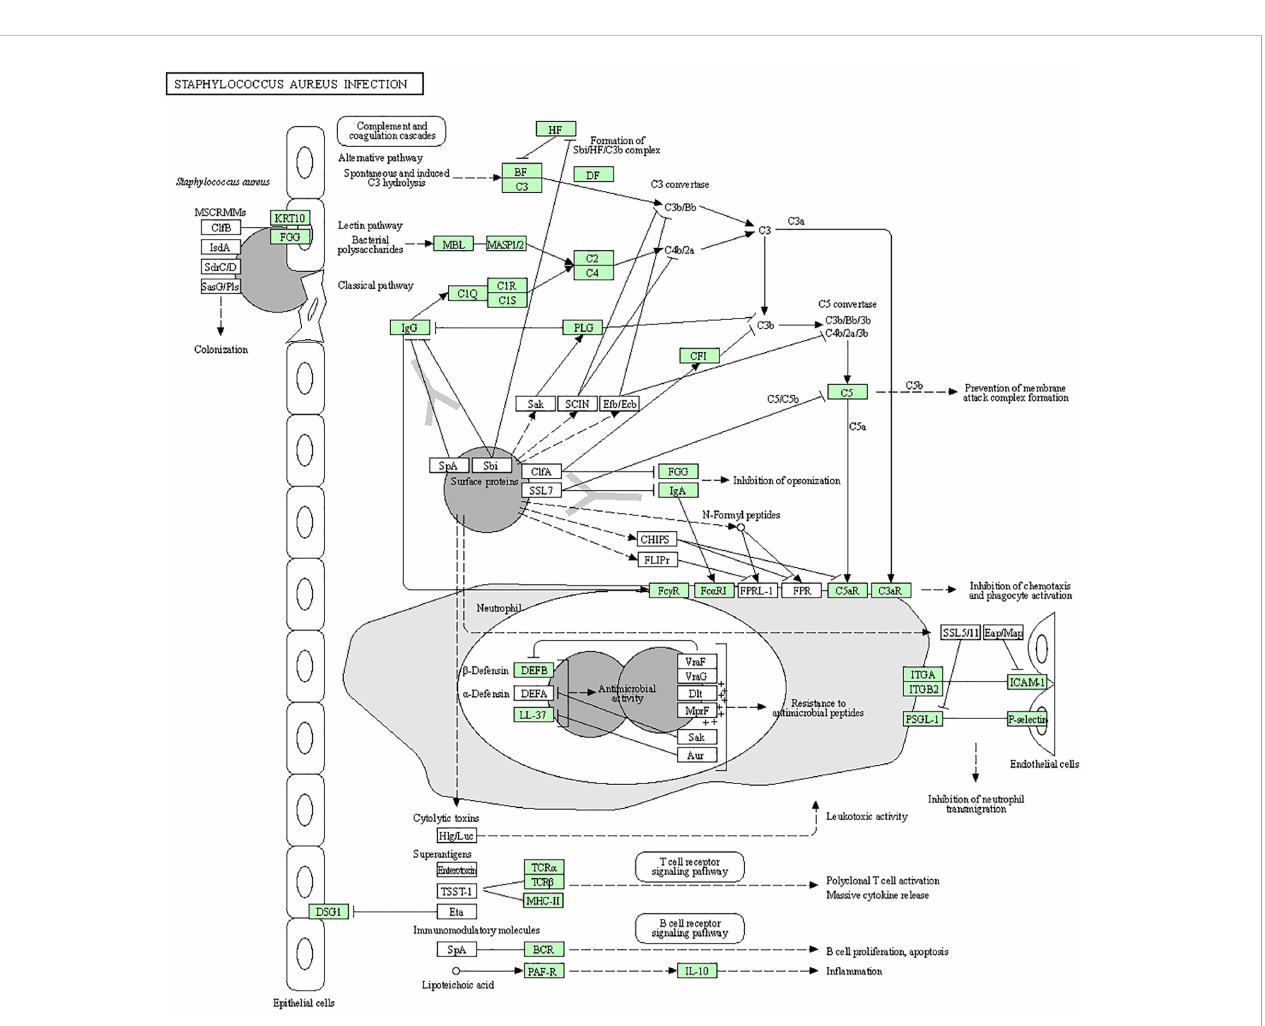
FIGURE 1 Staphylococcus aureus can cause multiple forms of infections ranging from super fi cial skin infections to food poisoning and life-threatening infections. The organism has several ways to divert the effectiveness of the immune system: secreting immune-modulating proteins that inhibit complement activation and neutrophil chemotaxis or lysis, modulating sensitivity to cationic antimicrobial peptides (such as defensin) by increasing the positive net charge of its cytoplasmic membrane, and the expression of superantigens that prevent the development of a normal immune response or cause an emetic response when